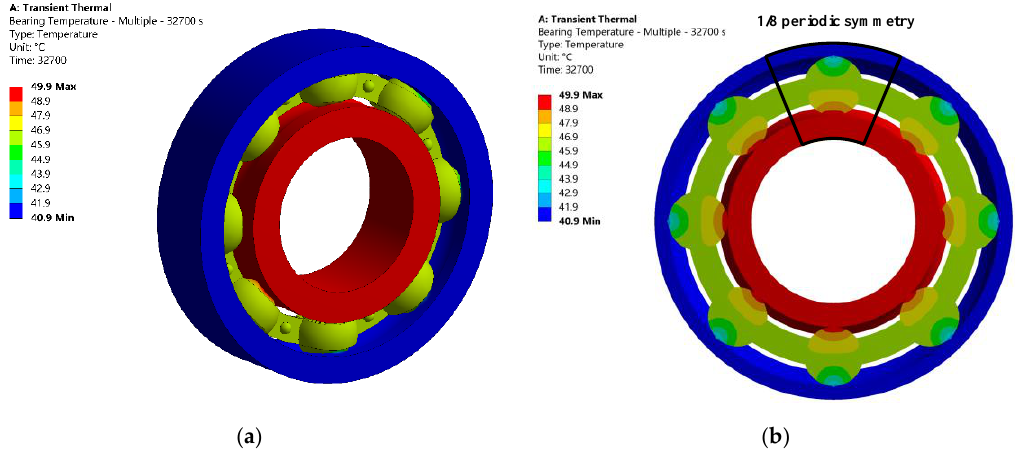
Figure 9. Temperature distribution of overall ball bearing and cross section after steady state: ( a ) overall ball bearing; ( b ) cross section.